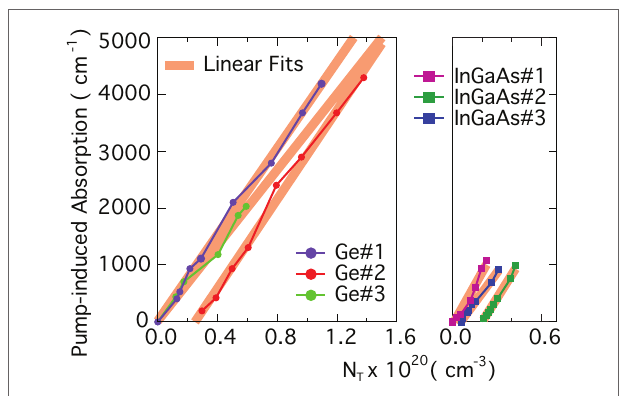
FiGURe 10 | Absorption coefficients for differently doped and strained Ge and inGaAs layers . The data are well described with a linear absorption cross-section